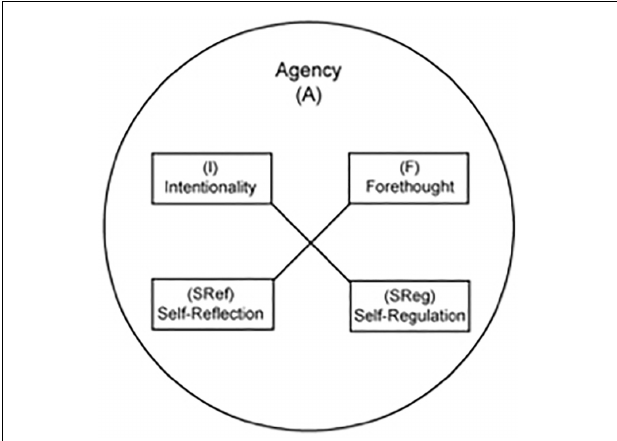
FIGURE 1 | A visual conceptualization of agency. I is intentionality; F is forethought; SReg is self-regulation; SRef is self-reflection (self-efficacy); and A is agency. The solid lines represent intentional, conscious emergent